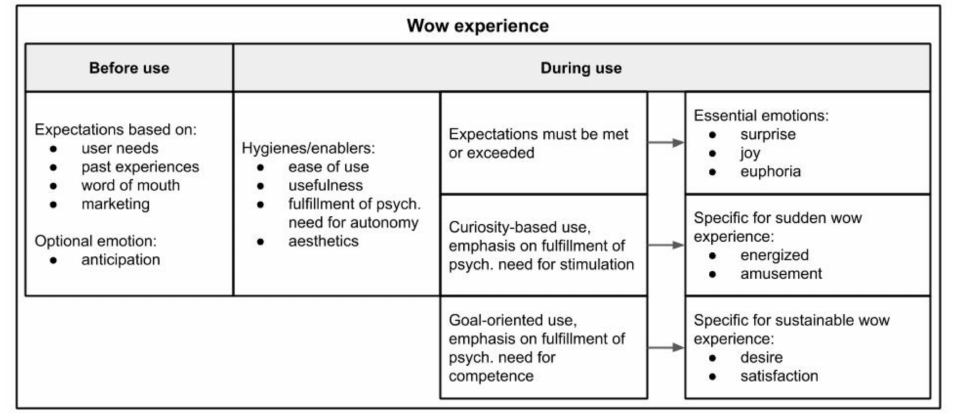
Figure 1. Integrated model of wow